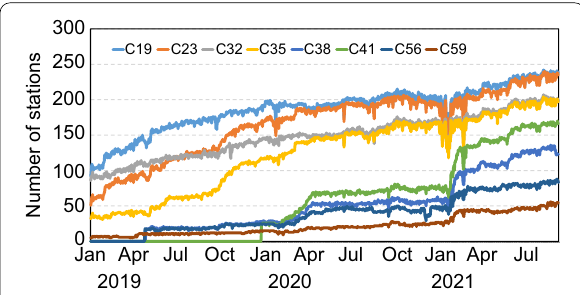
Fig. 4 The daily number of IGS and iGMAS stations tracking the representative BDS-3 satellites C19, C23, C32, C35, C38, and C59